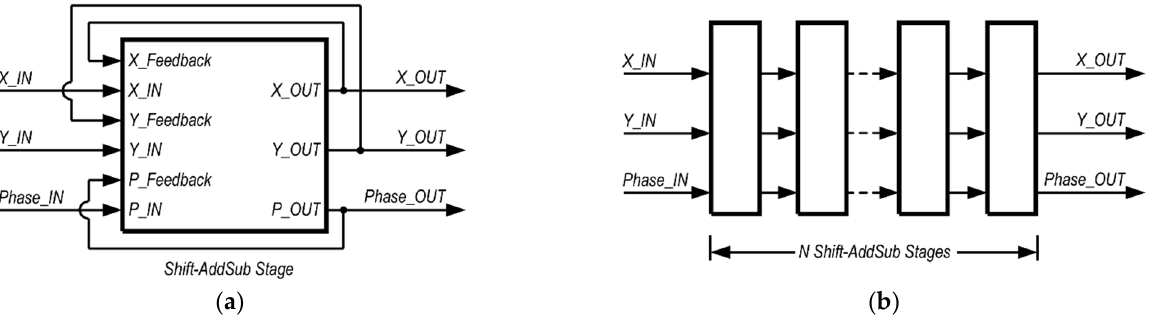
Figure 1. The Xilinx LogiCORE™ IP CORDIC architectural configurations: ( a ) word serial; ( b ) parallel.